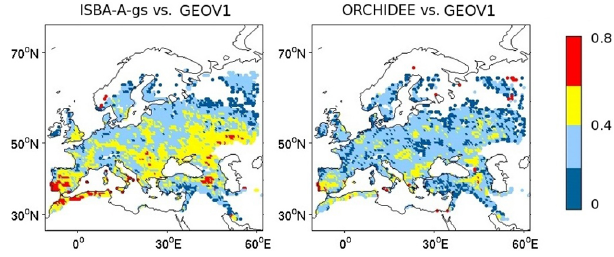
Figure 10. Pearson correlation coefficient ( r) between the scaled LAI 10-daily anomalies derived from detrended simulations (left, ISBA-A-gs; right, ORCHIDEE) and detrended GEOV1 satellite ob- servations, over the 1991–2008 period, at grid cells presenting sig- nificant positive correlations ( p value < 0.01).